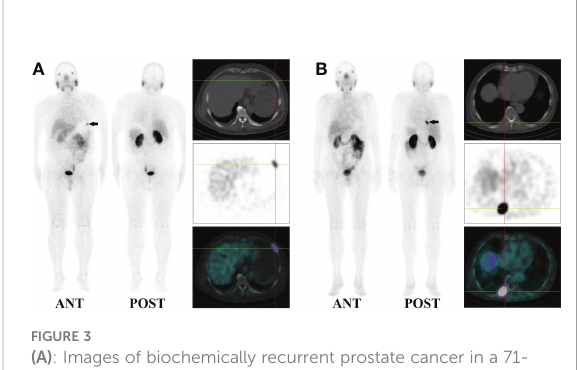
FIGURE 3 (A) : Images of biochemically recurrent prostate cancer in a 71- year-old male with increasing PSA levels after radical prostatectomy (PSA, 0.41 ng/ml; Gleason score,3+4). Whole- body planar scintigraphy (pointed by black arrow) and fused SPECT/CT images show high 99mTC-HYNIC-PSMA uptake (SUVmax, 2.97) in the left 6th rib. However, the corresponding CT showed no obvious bone destruction. The patient received ADT, and his PSA levels decreased to 0.10 ng/ml. (B) : Images of biochemically recurrent prostate cancer in a 59-year-old male with increasing PSA levels after radical prostatectomy (PSA, 6.30 ng/ml; Gleason score, 5 + 5). Whole-body planar scintigraphy (pointed by black arrow) and fused SPECT/CT images show high 99mTC-HYNIC-PSMA uptake (SUVmax, 8.63) in the right 8th rib, the corresponding CT showed obvious bone destruction. The patient received radiation therapy and his PSA level decreased to 0.31 ng/ml.